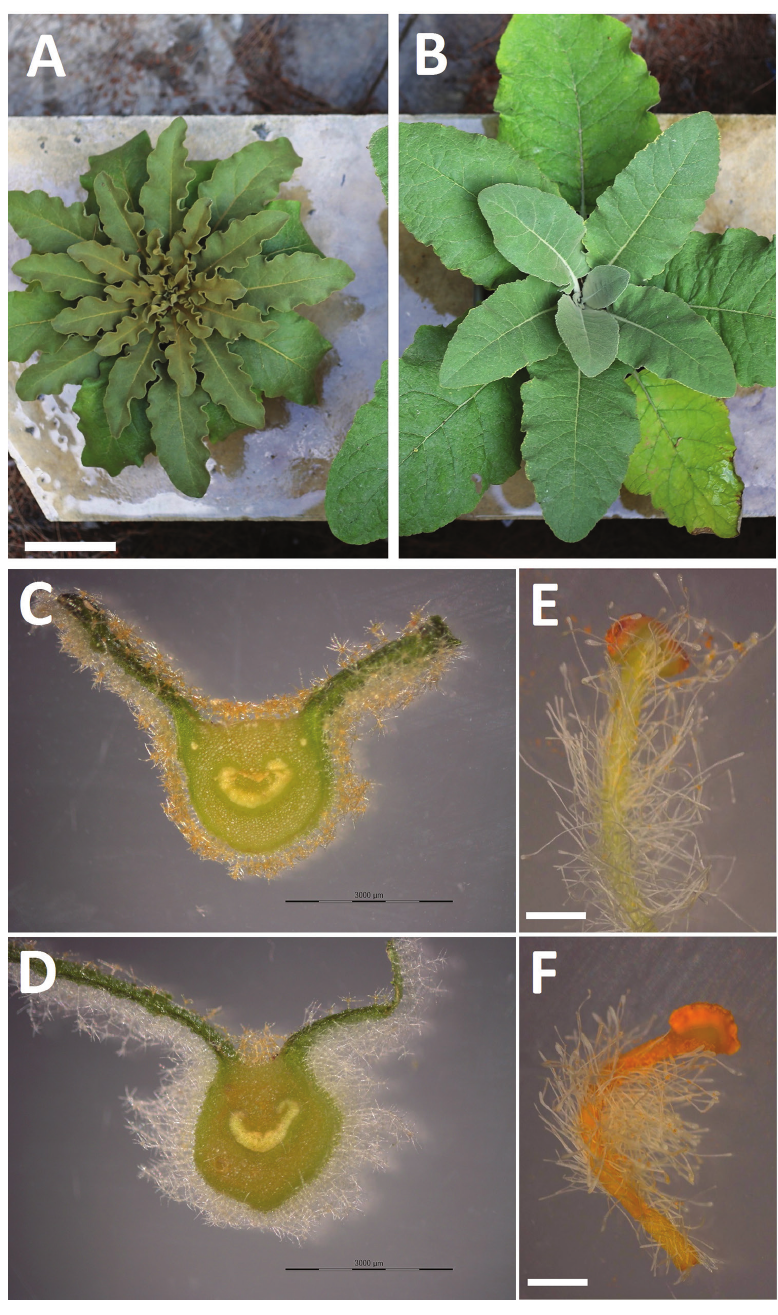
Figure 2. Comparative illustration of V. delphicum subsp. cervi and subsp. delphicum differential traits: A, C, E subsp. cervi B, D, F subsp. delphicum A, B first-year mature rosette-leaves of cultivated plants, bar = 10 cm C, D cross section of leaves indicating the shorter and darker indumentum of subsp. cervi , bars = 3 mm E, F anterior stamens, bars = 1